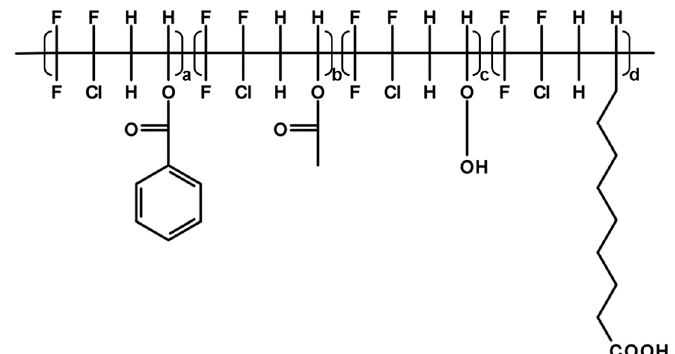
Figure 1. Chemical structure of the fluorocopolymer.